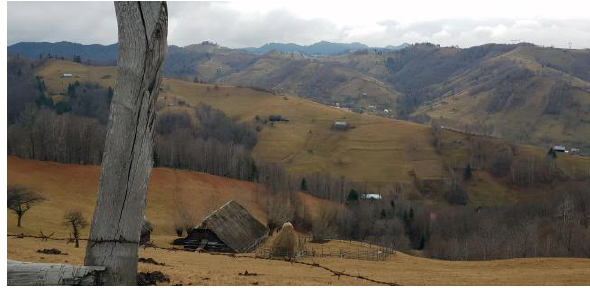
Figure 7. Cultural landscape of alpine pasture. Bran,